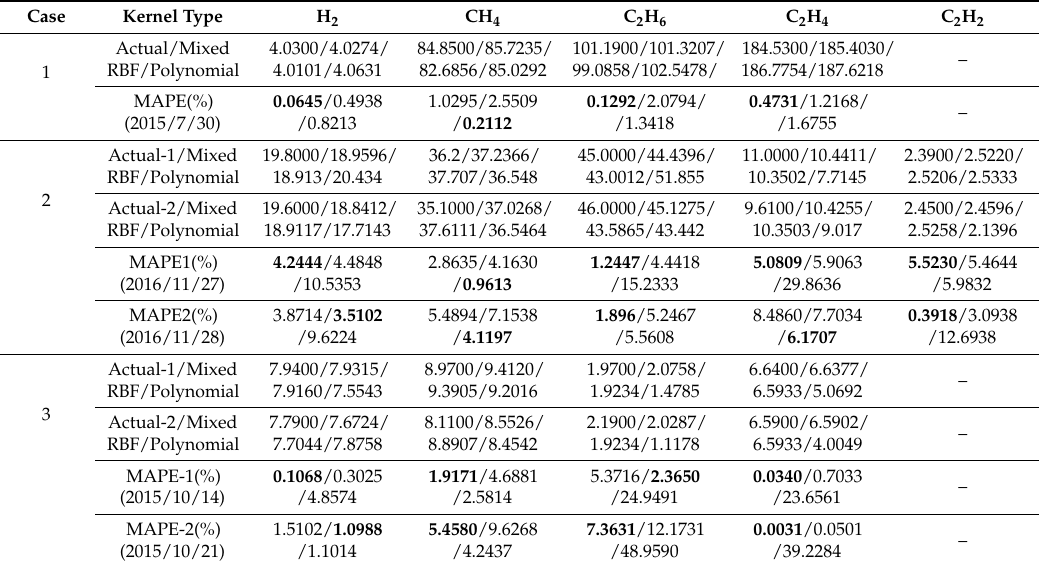
Table 6. The comparison of the forecasting result (testing